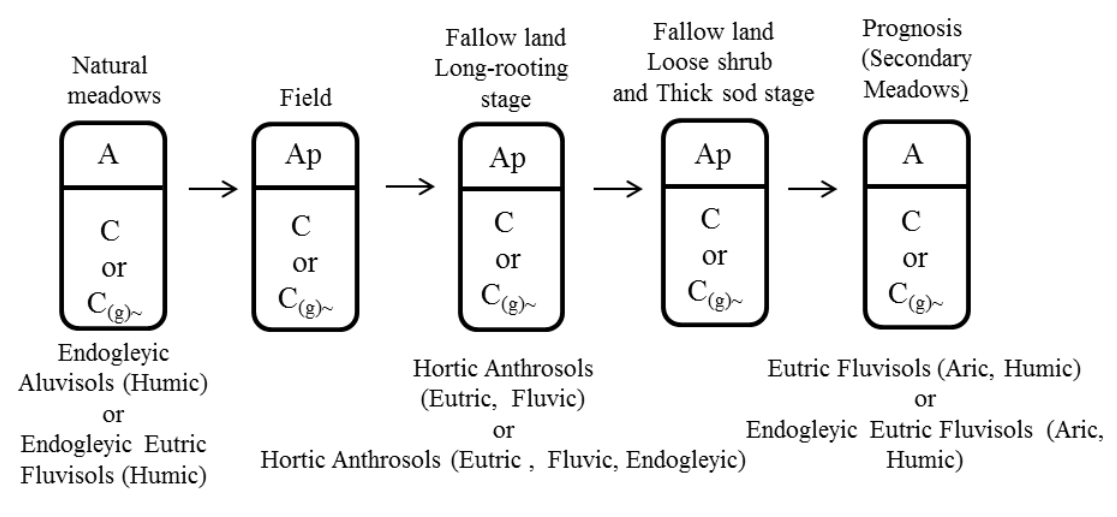
Fig. 2 Modifications of postagricultural alluvial soil formation in the Northern Dvina River delta floodplain.